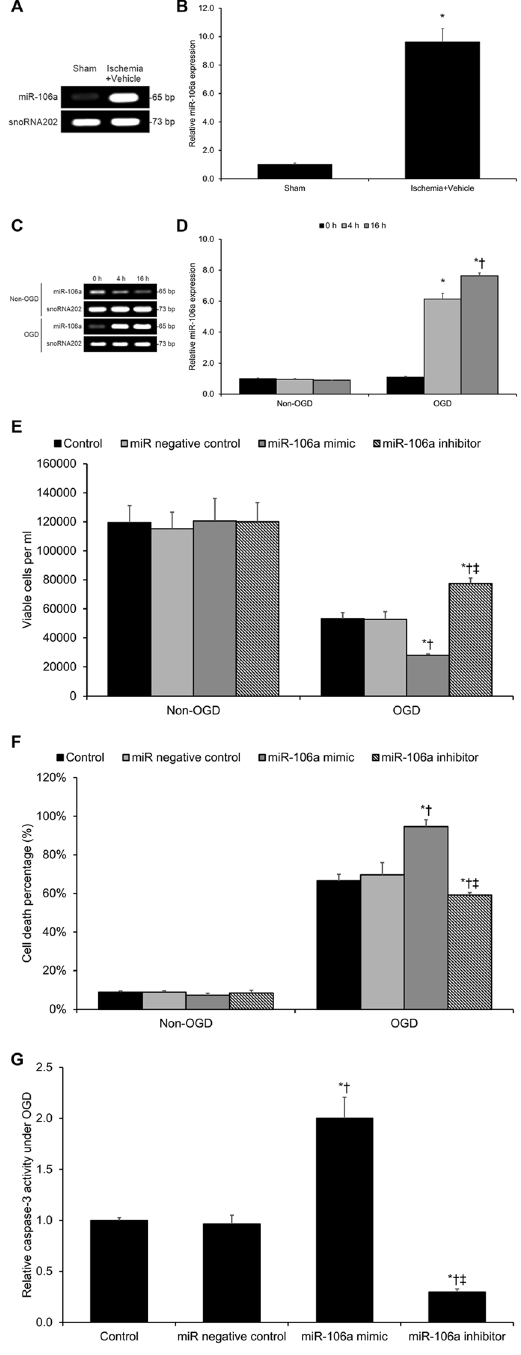
Figure 4. Ischemia-Induced miR-106a Upregulation Promotes OGD-Driven Cerebrovascular Endothelial Cell Death. ( A,B ) Real-time PCR on the total RNA content from cerebral microvessels extracted from wild-type mouse brains following middle cerebral artery (MCA) occlusion revealed cerebral ischemia-induced miR- 106a upregulation. Cropped blots are displayed here. * P < 0.05 versus sham group. ( C,D ) Real-time PCR on the total RNA content from murine cerebrovascular endothelial cells subjected to oxygen-glucose deprivation (OGD) exposure revealed OGD exposure time-dependent miR-106a upregulation. Cropped blots are displayed here. * P < 0.05 versus same-condition 0 h group, † P < 0.05 versus same-condition 4 h group. ( E–G ) Murine cerebrovascular endothelial cells were pre-treated with either a miR-106a mimic or a miR-106a inhibitor prior to OGD exposure. We assayed ( E ) cell viability by MTT assay, ( F ) cell death by the lactate dehydrogenase (LDH) method, and ( G ) caspase-3 activity. The miR-106a mimic significantly promoted OGD-driven cell death and caspase-3 activity, while the miR-106a inhibitor produced the opposite effects. Treatment with the scrambled- sequence microRNA negative control produced no significant effect. * P < 0.05 versus same-condition Control group, † P < 0.05 versus same-condition miR negative control group, ‡ P < 0.05 versus same-condition miR-106a mimic group. Data are reported as means ± standard errors of the mean